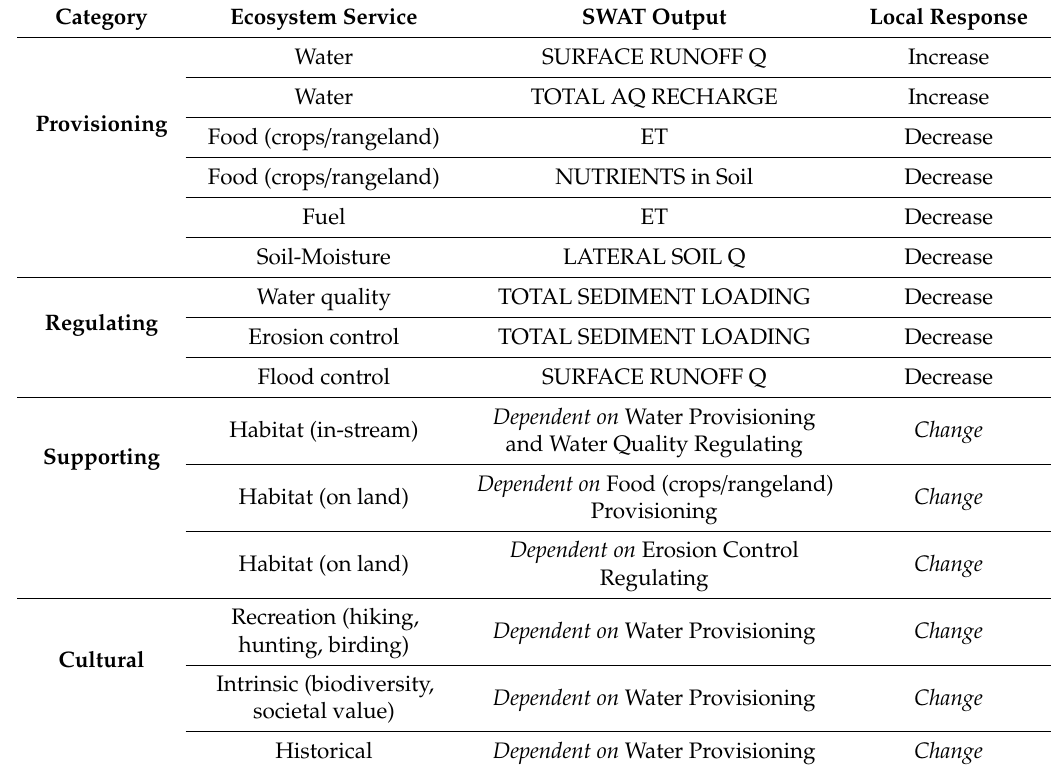
Table 2. Cross-walking ecosystem services, SWAT outputs and local response based on results between Current and Developed scenarios, from uncalibrated SWAT model